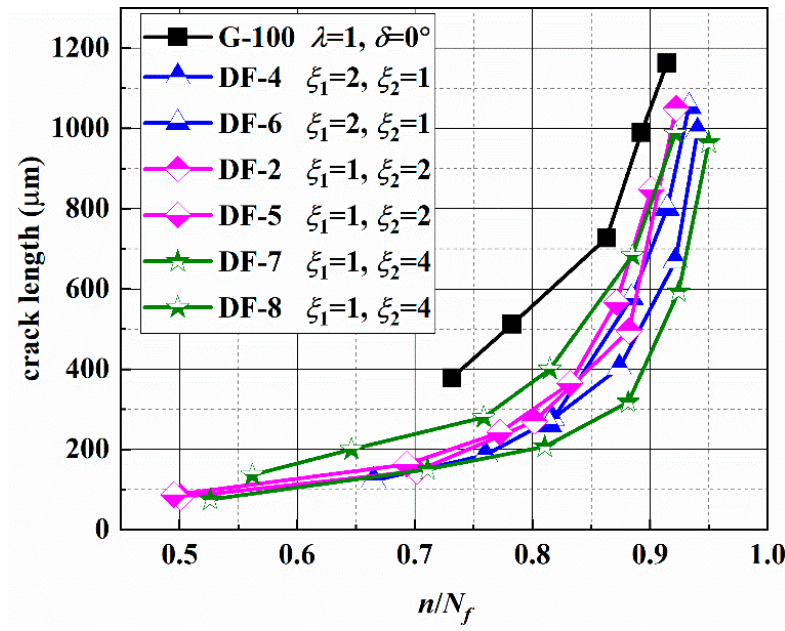
Figure 13. Crack length under different frequency